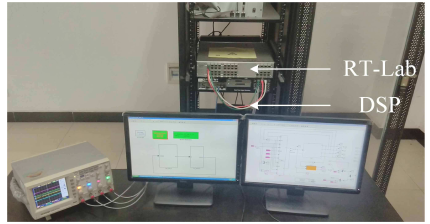
Figure 23. RT-LAB